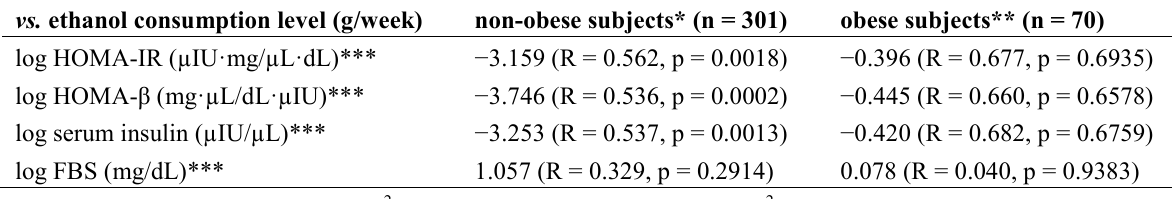
Table 3. Effects of BMI on relationship between levels of ethanol consumption and HOMA-IR, HOMA-β, insulin and FBS assessed by multiple regression analyses; t value (p value).